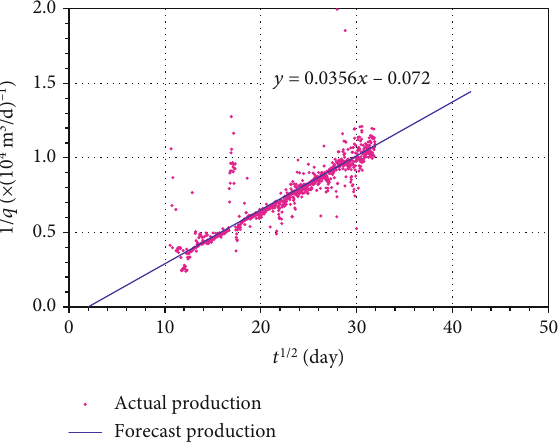
Figure 7: 1/ q vs. t 1/2 matching plot for C well. g